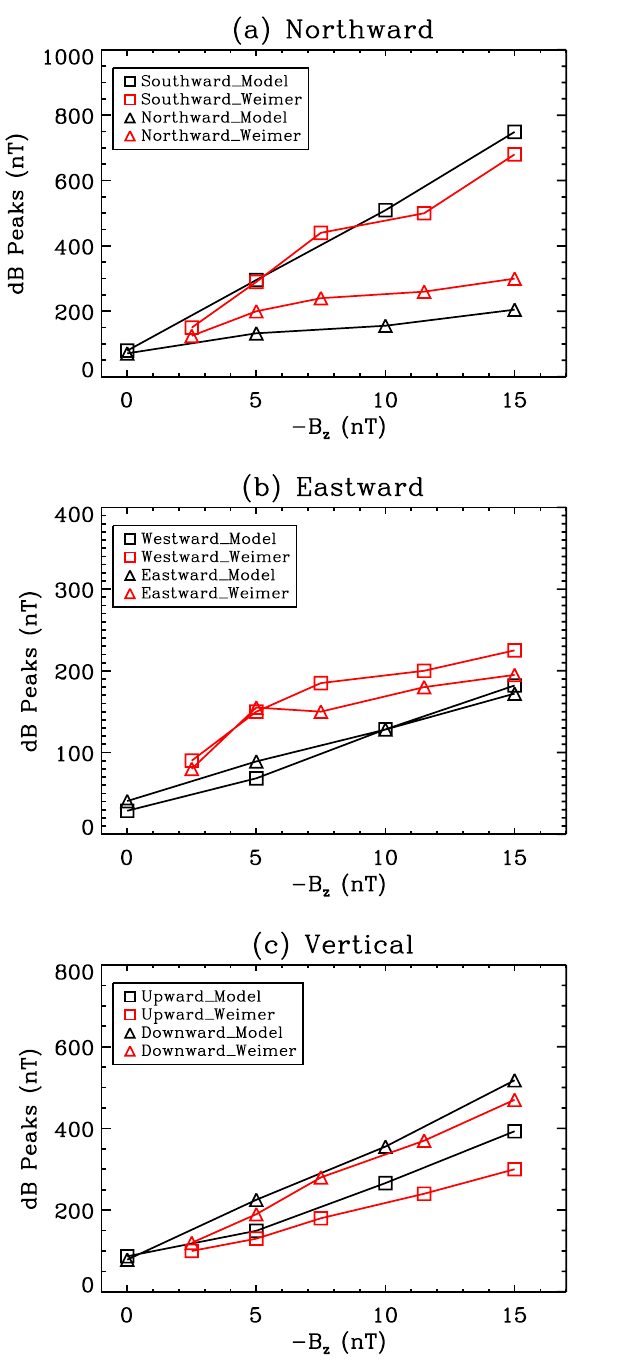
Fig. 8. Peak values of the geomagnetic perturbations as a function of the the southward IMF magnitude. From top to bottom three graphs show the (a) northward, (b) eastward, (c) vertical components. Tri- angle and square symbols represent the most positive and negative perturbation, respectively. Black lines denote the simulation results, red lines denote the statistical results.